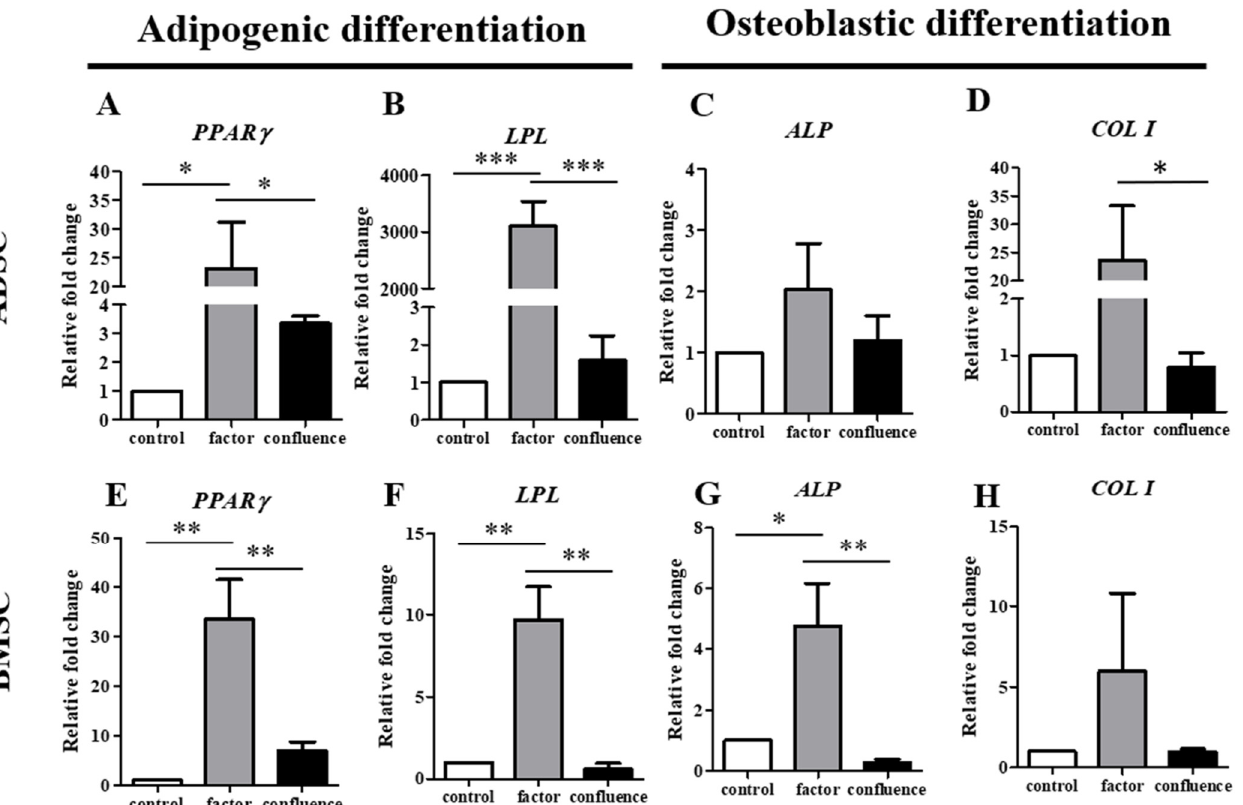
Figure 5. Detection of adipose-related and osteocyte-related gene expressions of the ADSCs and BMSCs during confluence-initiated differentiation. Adipose-related genes, including peroxisome proliferator-activated receptor γ ( PPAR γ ) ( A , E ) and lipoprotein lipase ( LPL ) ( B , F ), and osteocyte-related genes, including alkaline phosphatase ( ALP ) ( C , G ) and collagen type Ⅰ ( COL Ⅰ ) ( D , H ) of the ADSCs and BMSCs, after the factor-induced (factor) and confluence-initiated (confluence) differentiation on day 7 were detected by RT-qPCR. The value of each gene expression was normalized to the expression of glyceraldehyde-3-phosphate dehydrogenase ( GAPDH ). Relative fold changes of the values of the factor-induced and confluence-initiated differentiated ADSCs were compared with the value of the control (without induction) as one. The values are expressed as mean ± SEM with three experimental replicates. Statistical significance was determined using the one-way ANOVA test. “*” represents p < 0.05. “**” represents p < 0.01. “***” represents p < 0.001.